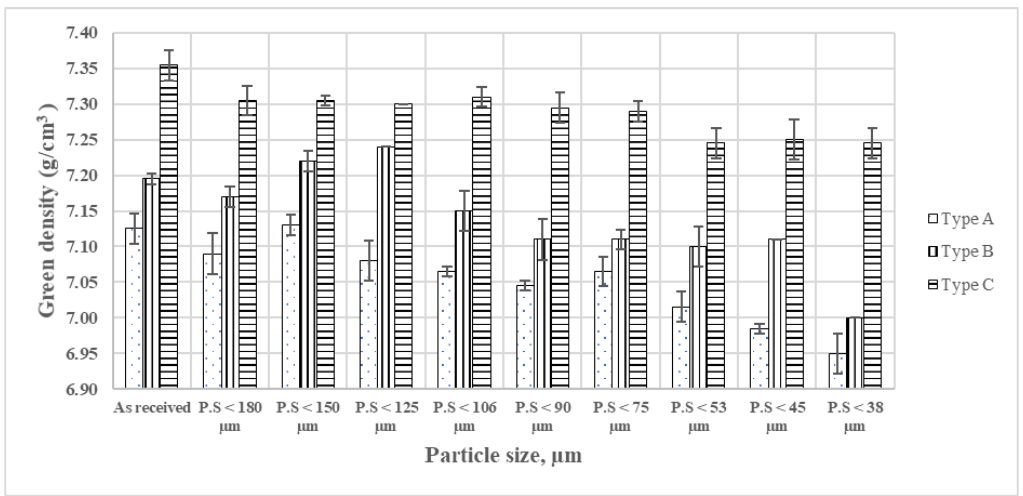
Figure 8. Densities of pure iron powder without adding lubricant, after achieving the terminal load of 49 KN. The notation P.S. < a μ m means that all particles with sizes greater than a μ m were